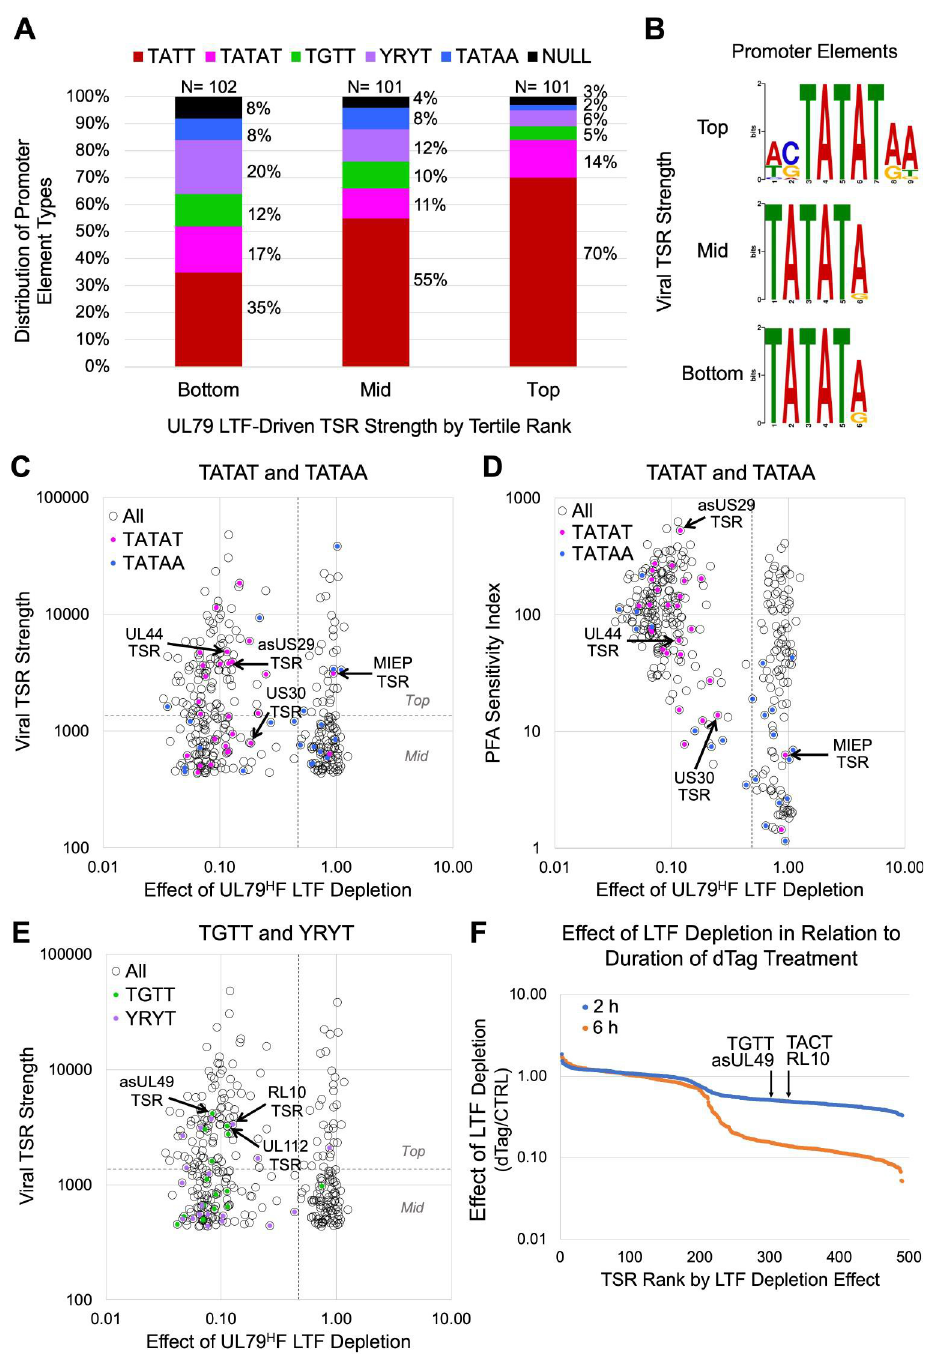
Fig 7. Noncanonical sequences in LTF-responsive promoters. ( A ) Proportional distribution of different motif types in LTF-responsive promoters by tertile rank in TSR strength. Based on effects of UL79 H F LTF depletion (6-h dTag treatment) on viral TSR strength at 72 hpi. Null, unclassified sequence. ( B ) MEME logo determination for UL87 LTF- responsive TSRs having a TATAT positioned -50 to -20 relative to MAXTSS by tertile rank in TSR strength. ( C-E ) Effect of UL79 H F LTF depletion on viral TSR strength at 72 hpi versus baseline TSR strength (C and E) or PSI (D) for viral TSRs � 435 nascent RNA reads (open circles). Viral TSRs with TATT (red), TATAT (pink), TATAA (blue), TGTT (green), or YRYT (violet) sequences positioned -40 to -28 relative to MAXTSS are marked with dots colored accordingly. Horizontal dashed line divides top and mid TSR strength tertiles. ( F ) Effect of dTag treatment for 2 versus 6 h on viral TSR strength (dTag/CTRL) at 96 hpi for HCMV UL87 H F. Viral TSR strength was determined by